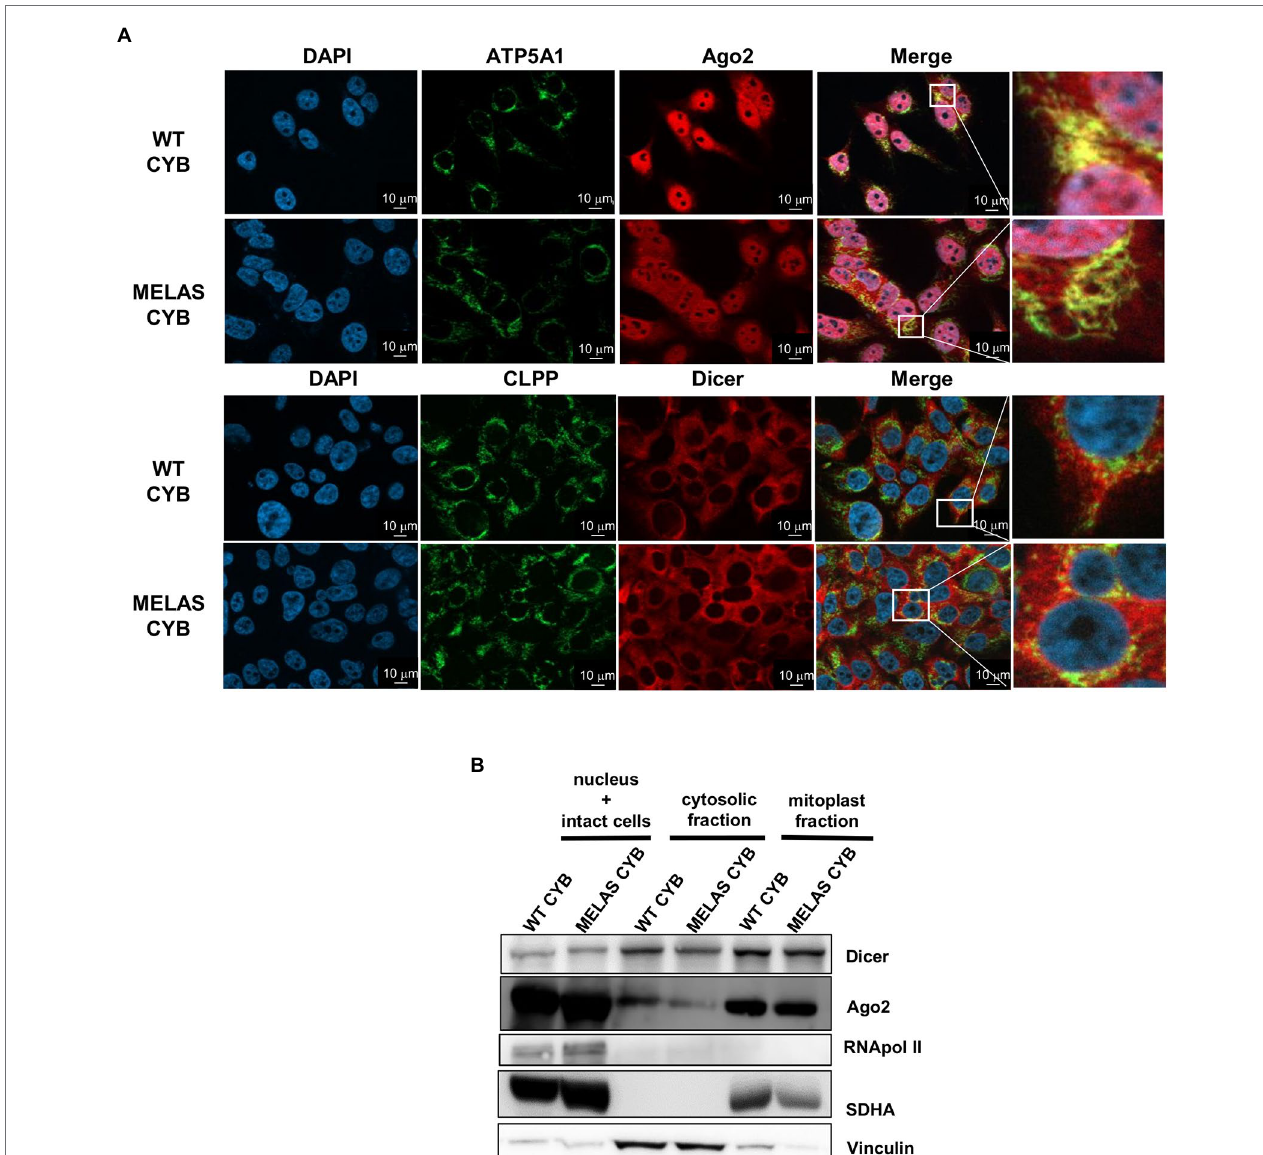
FIGURE 1 | Partial localization of Dicer and Ago2 in the mitochondrial fraction of WT and MELAS cybrid cells. (A) Immunofluorescence microscopy analysis of endogenous Dicer and Ago2 subcellular localization in WT and MELAS cybrid cells. Nuclei were stained with DAPI (blue), and mitochondria were immunodetected with anti-ATP5A1 (OXPHOS Complex V subunit) or anti-CLPP (a serine protease located in the mitochondrial matrix). Scale bars, 10 μ m. (B) Representative immunoblots of Dicer and Ago2 in subcellular fractions of WT and MELAS cybrid cells. Dicer and Ago2 levels were determined in nucleus and intact cells, cytosol and mitoplasts enriched fractions together with respective markers (Pol II (nucleus), Vinculin (cytoplasm), and SDHA